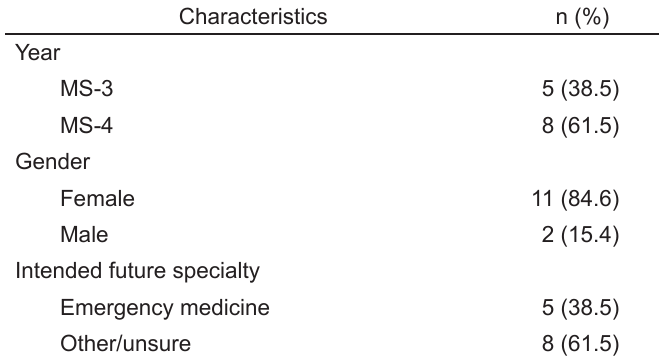
Table 2. Qualitative interviewee characteristics (N=13).